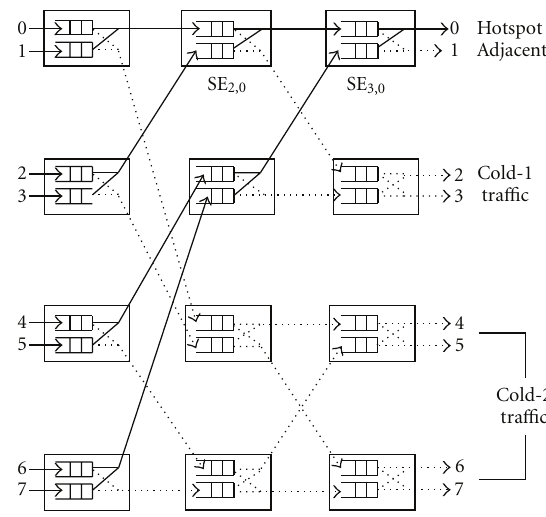
Figure 1: A single-layer 8 × 8 MIN under hotspot tra ffi